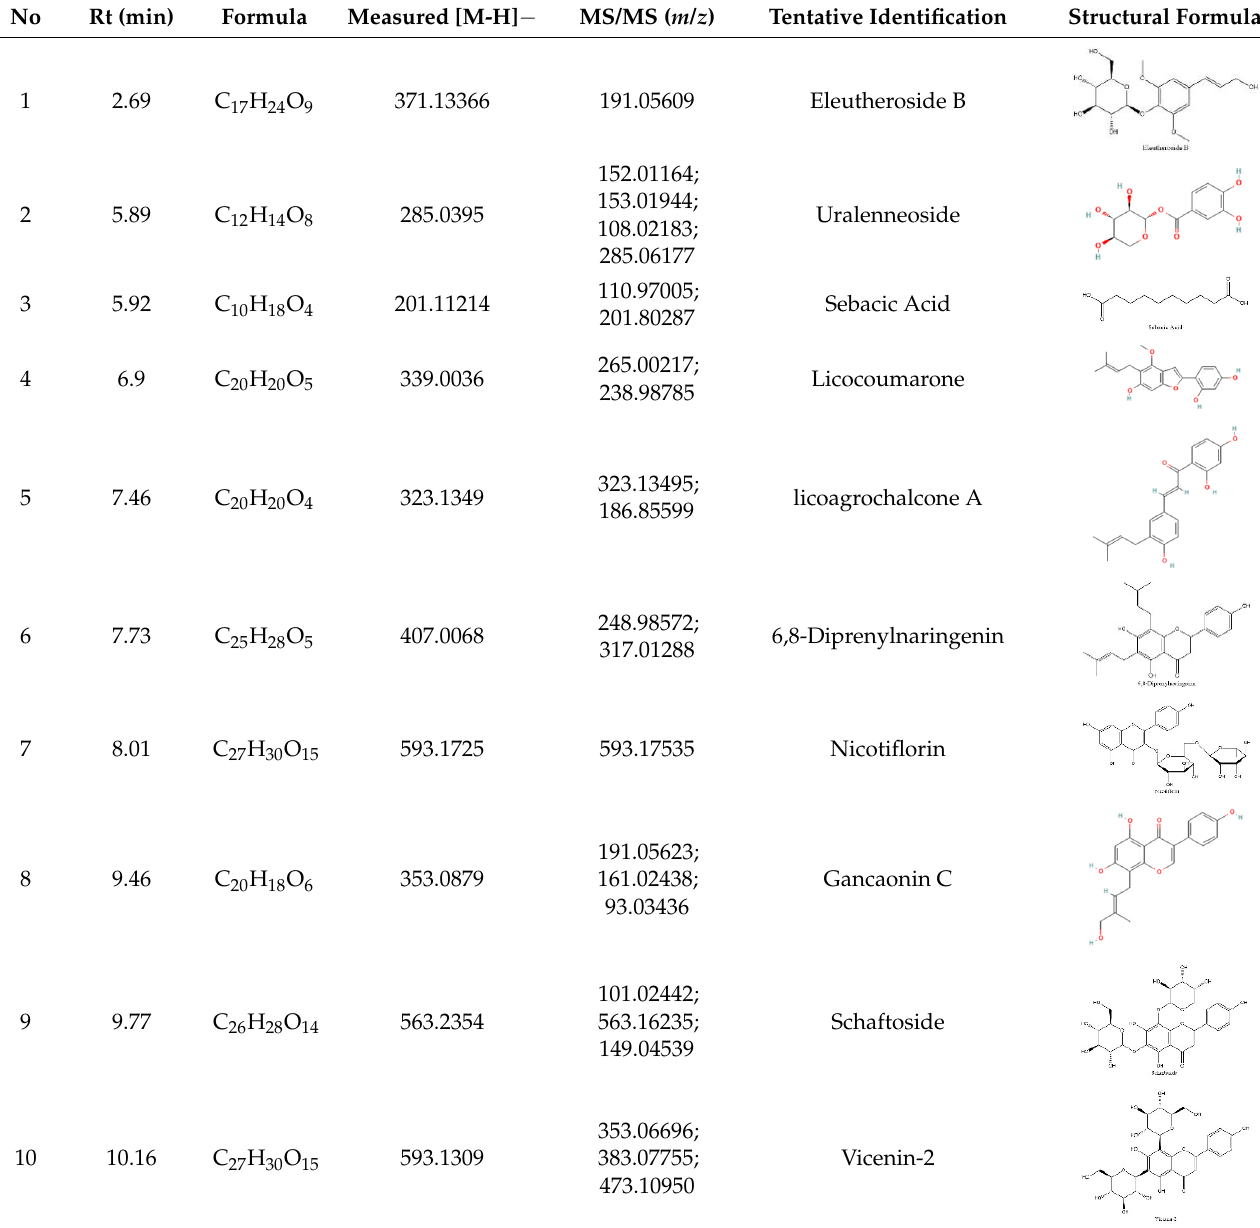
Figure 1. Chemical composition identification in GDK by LC-Orbitrap-ESI-MS. Table 1. Identified bioactive components of GDK with LC-Orbitrap-ESI-MS.